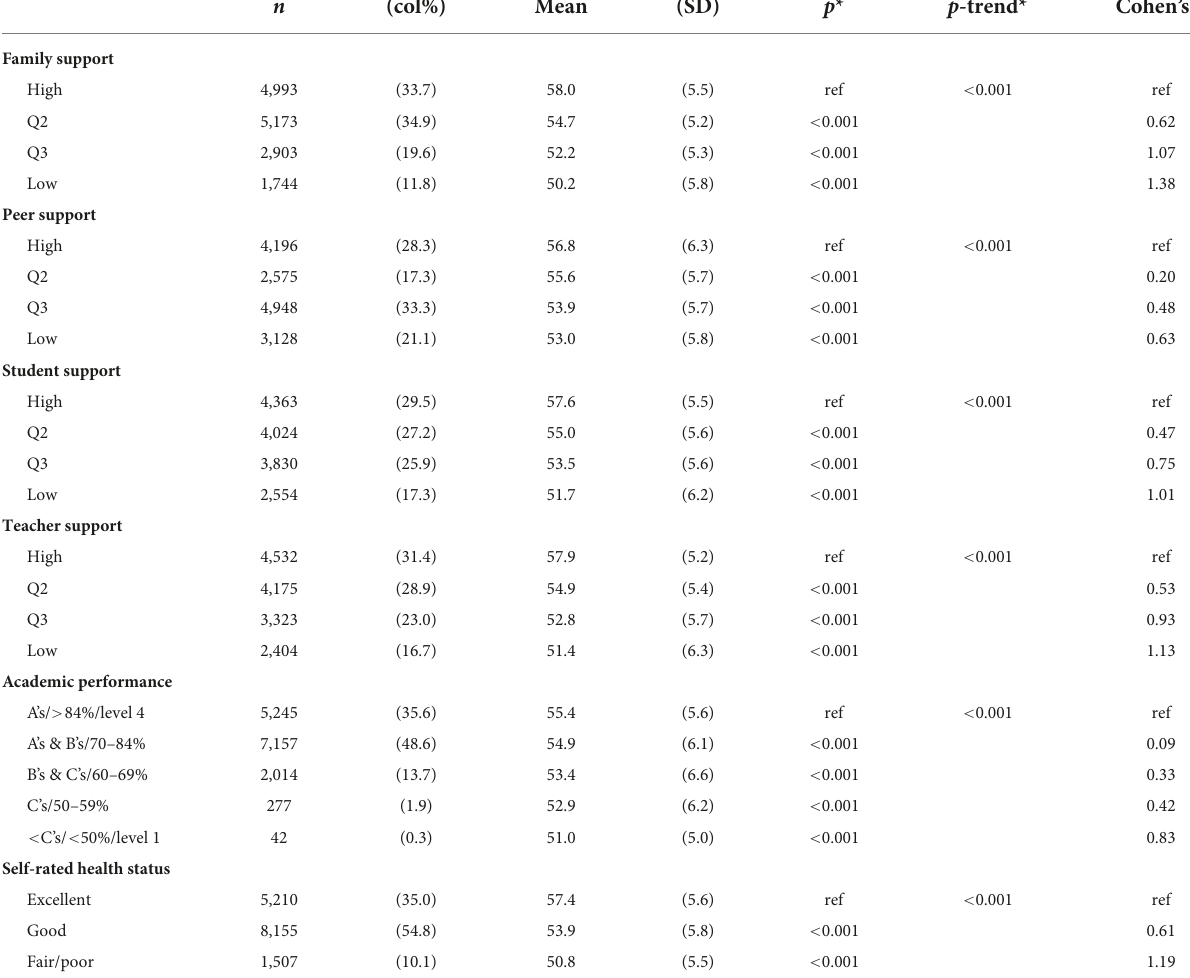
TABLE 2 Description of the average mental health score by indicators of social support, academic functioning, and self-rated health in “mentally healthy” adolescents according to the categorical dual-factor measure † [weighted n = 14,994 (67.6% of the full sample)].